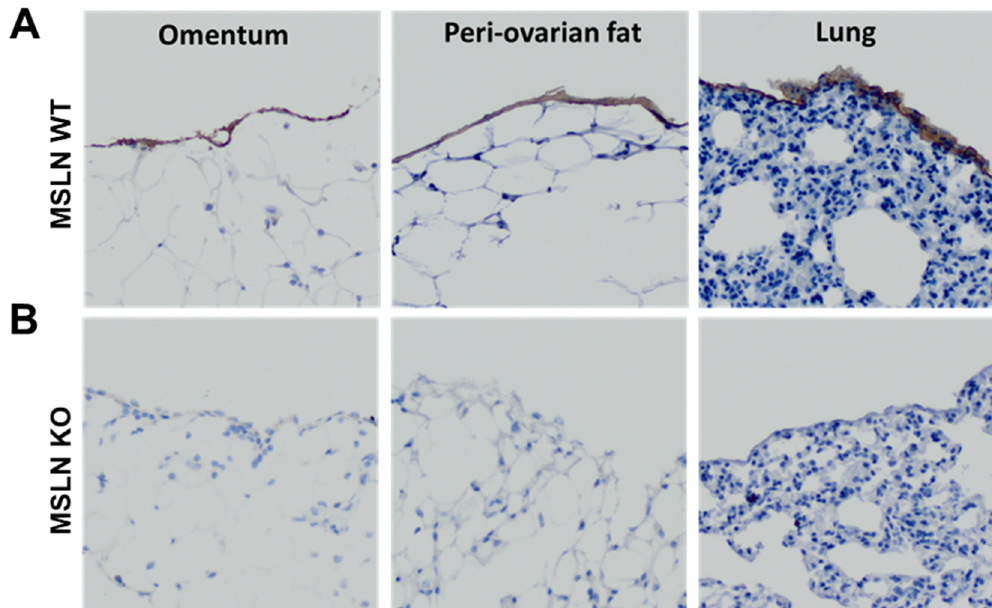
Figure 1. Immunohistochemical detection of MSLN. Normal omentum, peri-ovarian fat, and lung tissues were dissected from ( A ) MSLN WT and ( B ) MSLN KO and were immunohistochemically stained for mesothelin. Expression was confirmed in MSLN WT mice and absent in MSLN KO mice. Images taken at 20×.